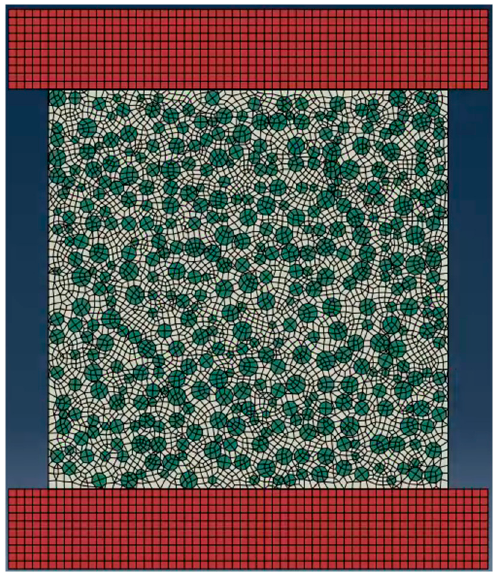
Figure 4. Test simulation diagram.